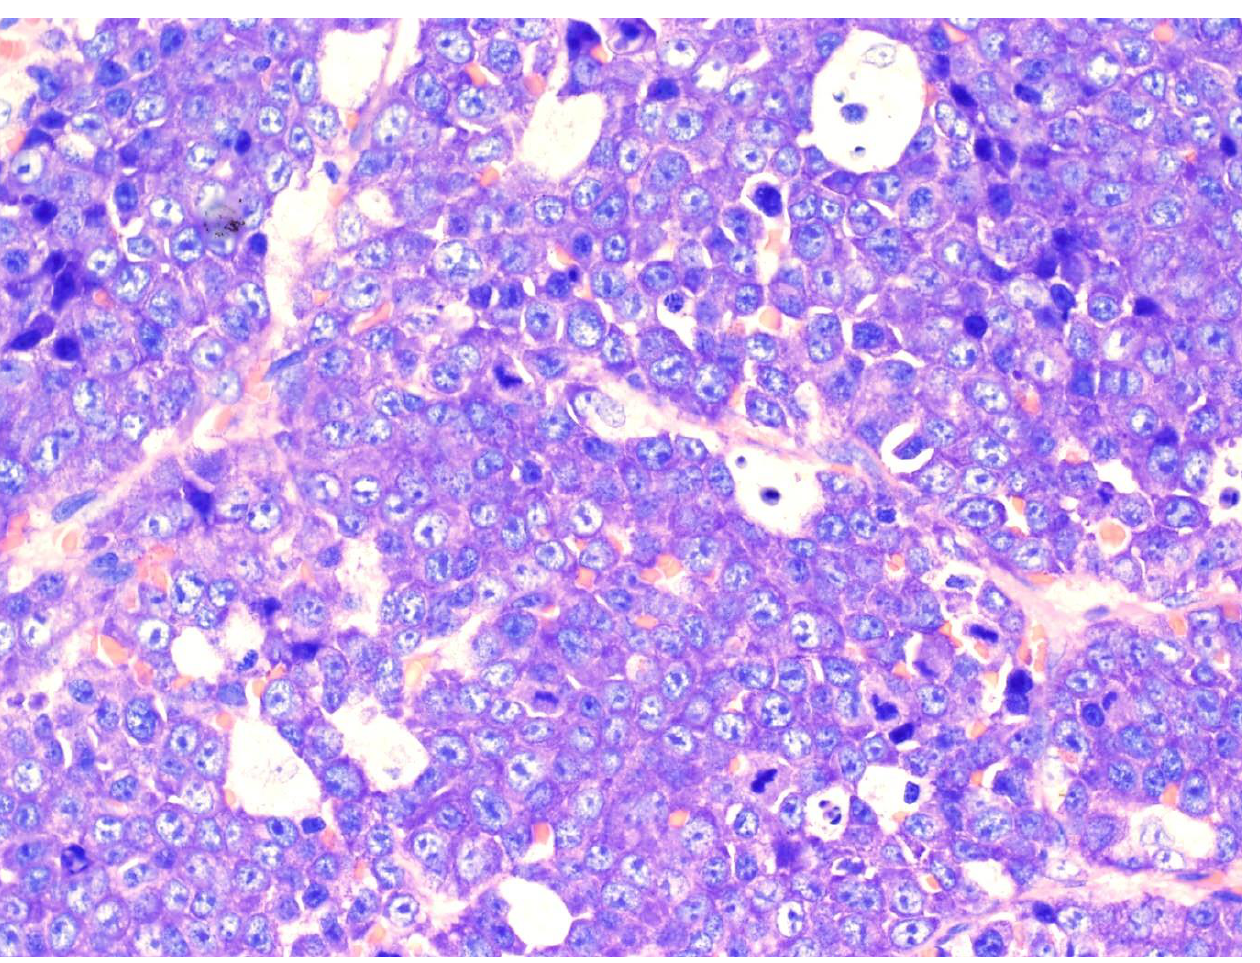
Figure 10. Plasmablastic lymphoma (Giemsa ×400). This photomicrograph shows cohesively ar- ranged immunoblastic/plasmablastic cells with broad deeply basophilic cytoplasm. In this case, CD20 was negative, and both CD138 and MUM1 were strongly